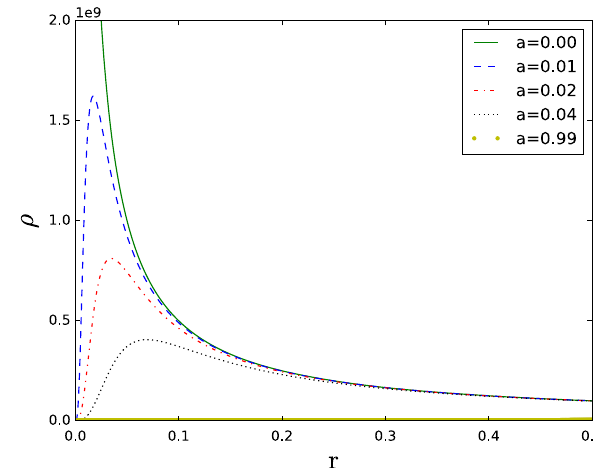
Fig. 2 The behavior of dark matter’s ρ + p with radial distance r . The modeling parameters are θ = π/ 2, ω = 0, R s (or R and R c ) = 10, r 0 = 1, ρ s (or ρ 0 ) = 0.05 and a = 0 . 5